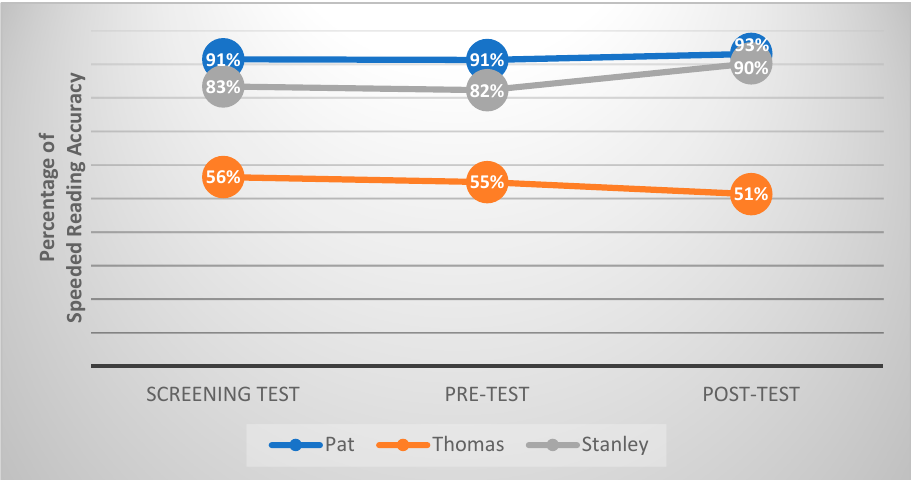
Figure 2. The speeded reading accuracy by each child within 45 s across all time points.